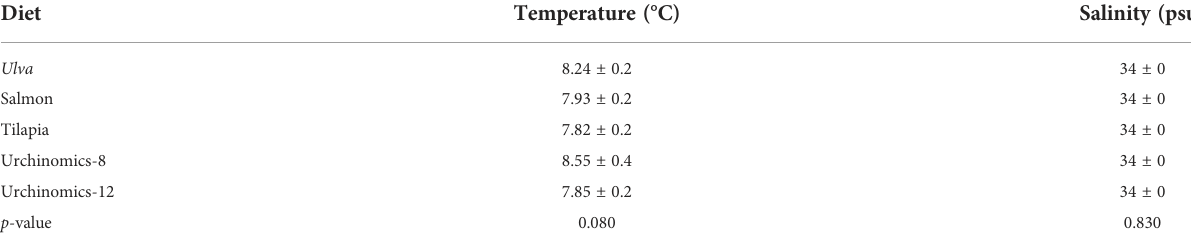
TABLE 2 Mean ( ± SE) seawater parameters measured throughout the feed trial within